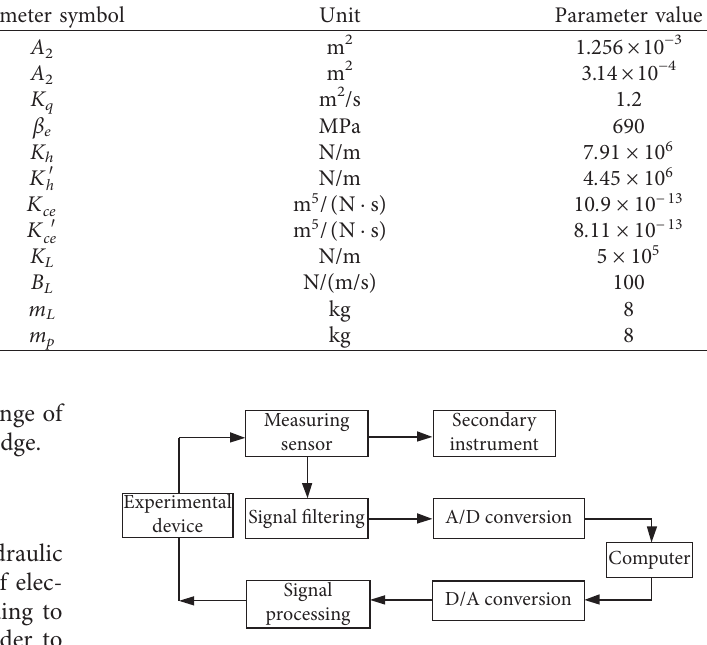
Figure 8: The principle of the test